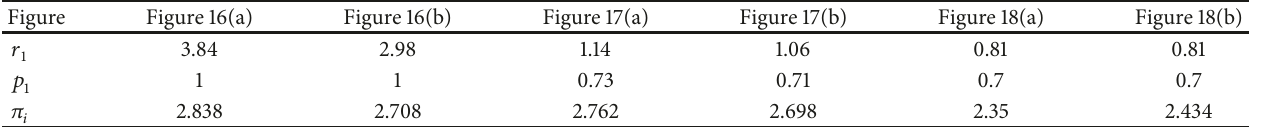
Table 1: Maximal profits and their